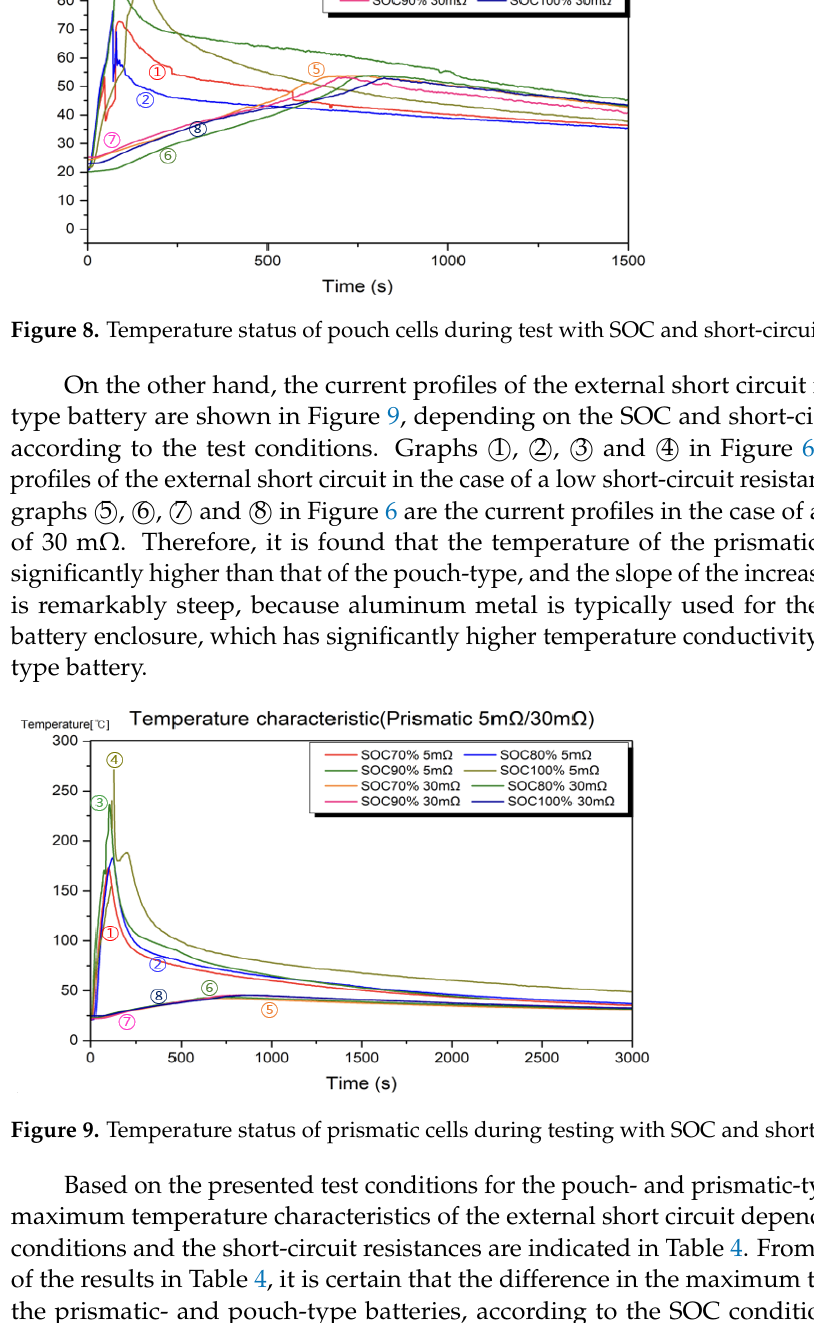
Table 4. Maximum temperatures during external short circuit. Max Temperature (°C)